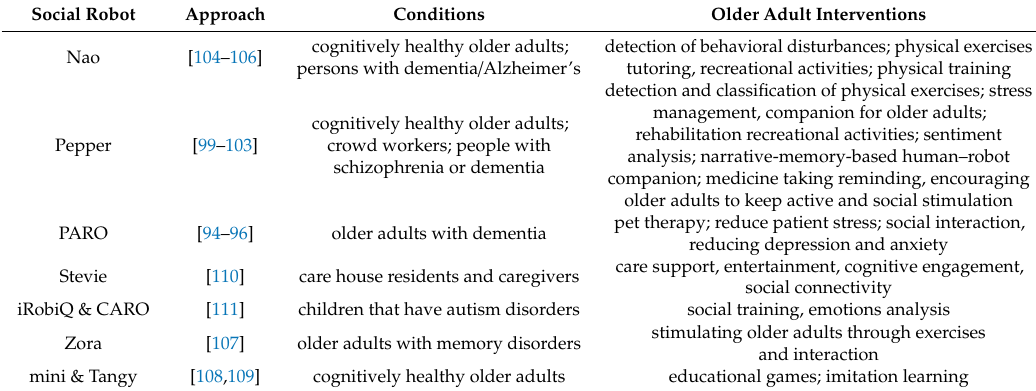
Table 3. Social robots’ intervention approaches in research